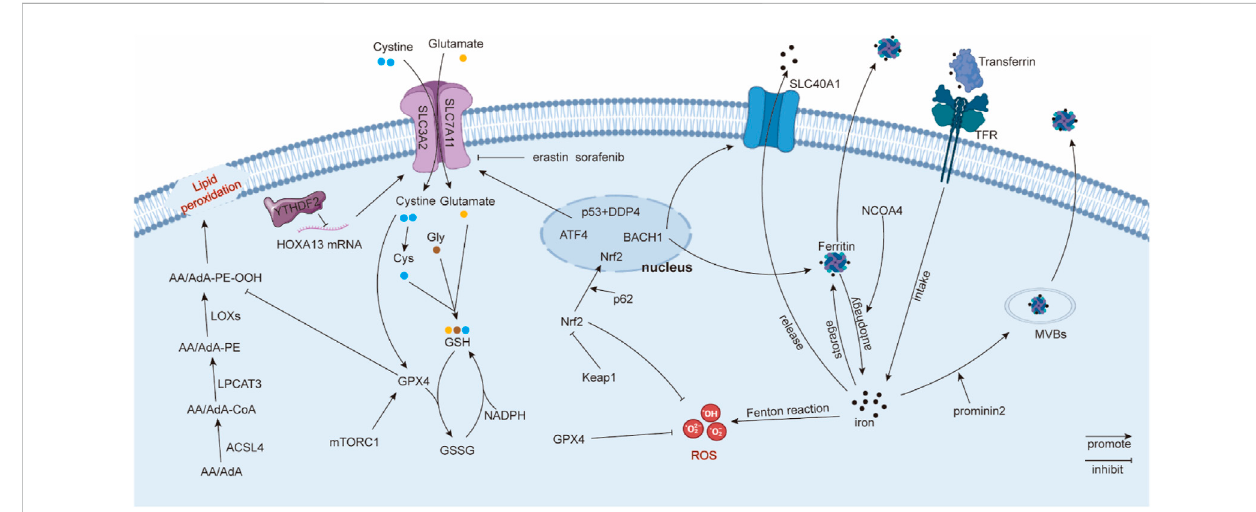
FIGURE 1 Regulatorymechanismsinferroptosis.Solutecarrierfamily40member1(SLC40A1);ferritinheavychain1(FTH1);ferritinlightchain1(FTL1);reactive oxygen species (ROS); phosphatidylethanolamines (PE); arachidonoyl (AA) adrenoyl (AdA); lipoxygenases (LOXs); polyunsaturated fatty acids (PUFA); phospholipids (PL-OOH); and lyso-phosphatidylcholine acyltransferase 3